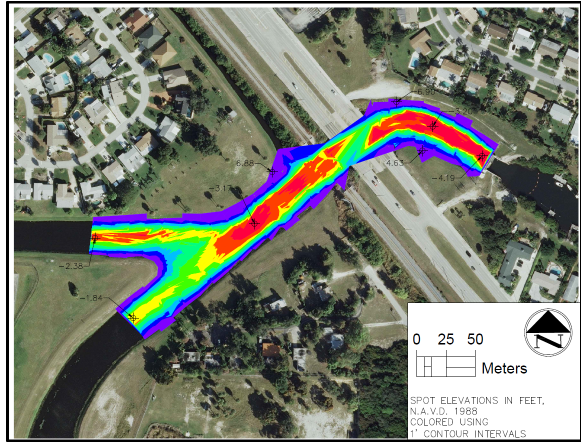
Figure 5: Hydrographic map of Earman River